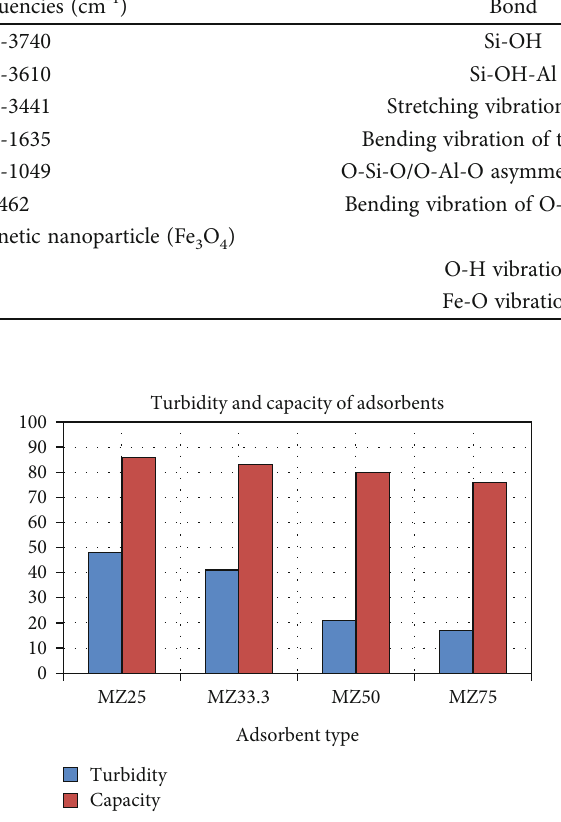
Figure 4: Turbidity of fi ltrate and adsorption capacity of magnetic